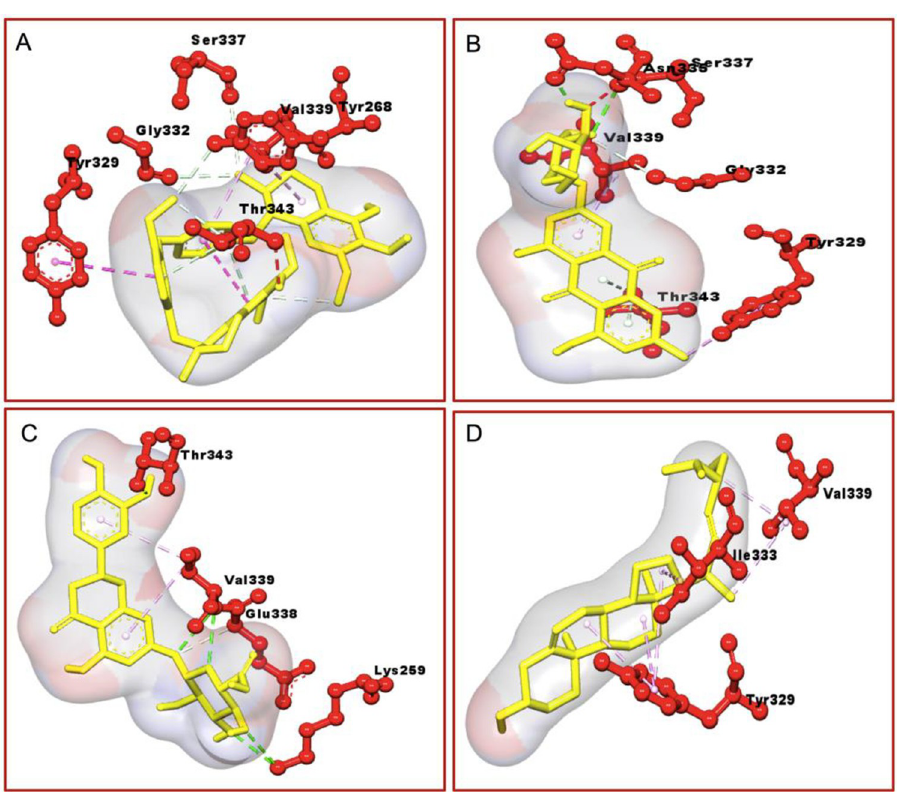
Fig 2. 3D structure of active phytoconstituents in complex with 1R9W: (A) Thalirugonidine, (B) Clicoemodin, (C) Eriodictyol-7, and (D) Stigmasterol.